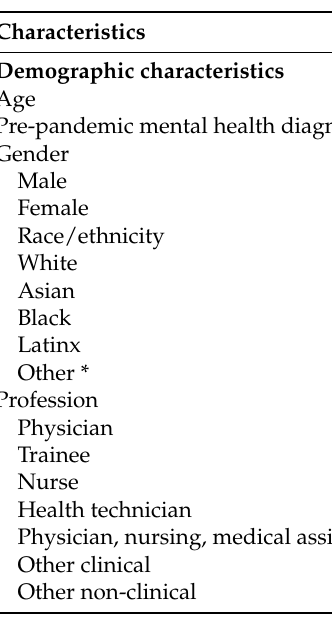
Table 1. Participant